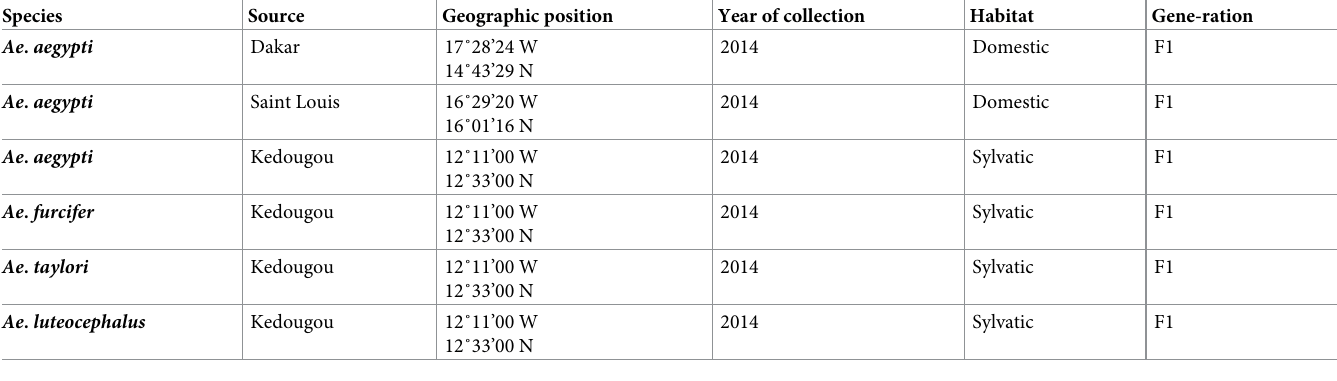
Mosquito species used in this study were collected from three Senegalese localities: Dakar, Saint Louis and Kedougou (Fig 1). The Table 1 describes the characteristics and geographic origins of Ae . aegypti , Ae . furcifer , Ae . taylori , and Ae . luteocephalus populations tested. The sylvatic Ae . aegypti population from Kedougou breeding in tree holes represented Ae . aegypti formosus morphologically characterised by the lack of pales scales on the first abdominal ter- gite and the urban populations from Dakar and Saint Louis breeding in artificial containers were consistent with Ae . aegypti aegypti contrariwise characterised by the presence of pales scales. These species were chosen based on their abundance, anthrophophilic behavior and Table 1. Mosquito species tested in this